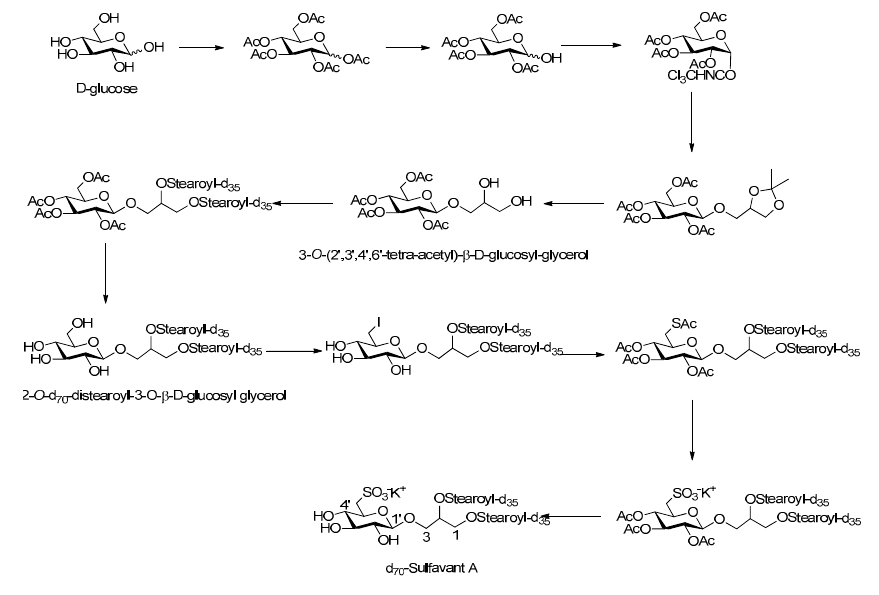
Figure 2. Chemical synthesis of deuterated Sulfavant A. Table 1. Gradient program of the Ultra High Performance Liquid Chromatography (UHPLC)